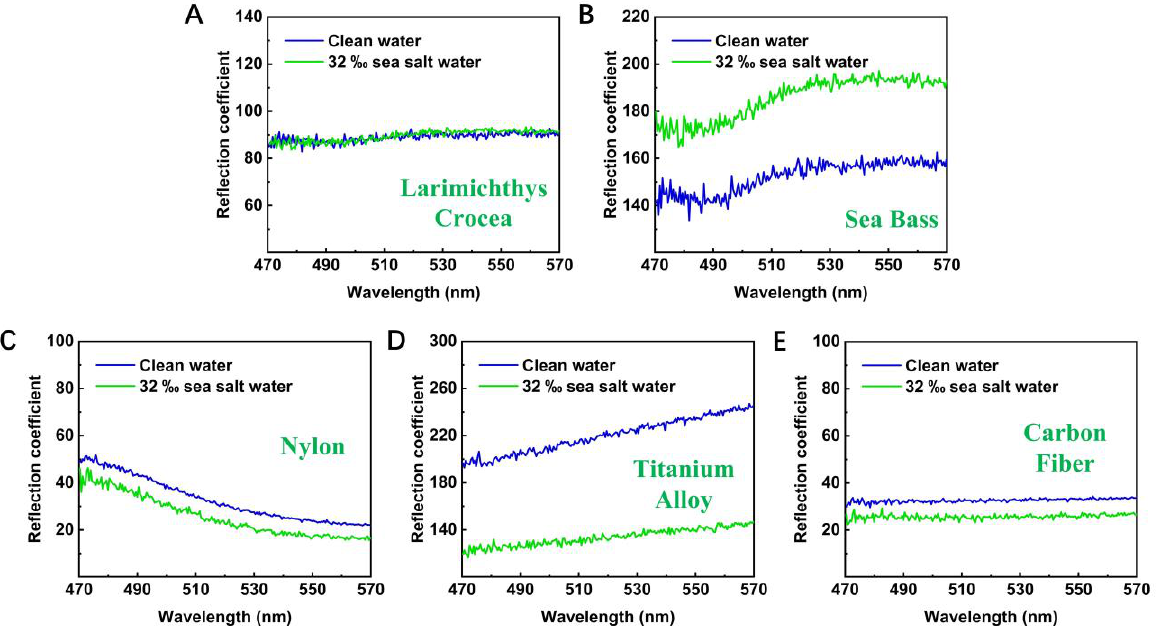
Figure 4. Average data ( 𝑅 𝐶 ) of various materials in clean water and water with salinity of 32‰, the type of material is marked in the subgraph. ( A ) Larimichthys crocea. ( B ) Sea bass. ( C ) Nylon. ( D ) Titanium alloy. ( E ) Carbon fiber.